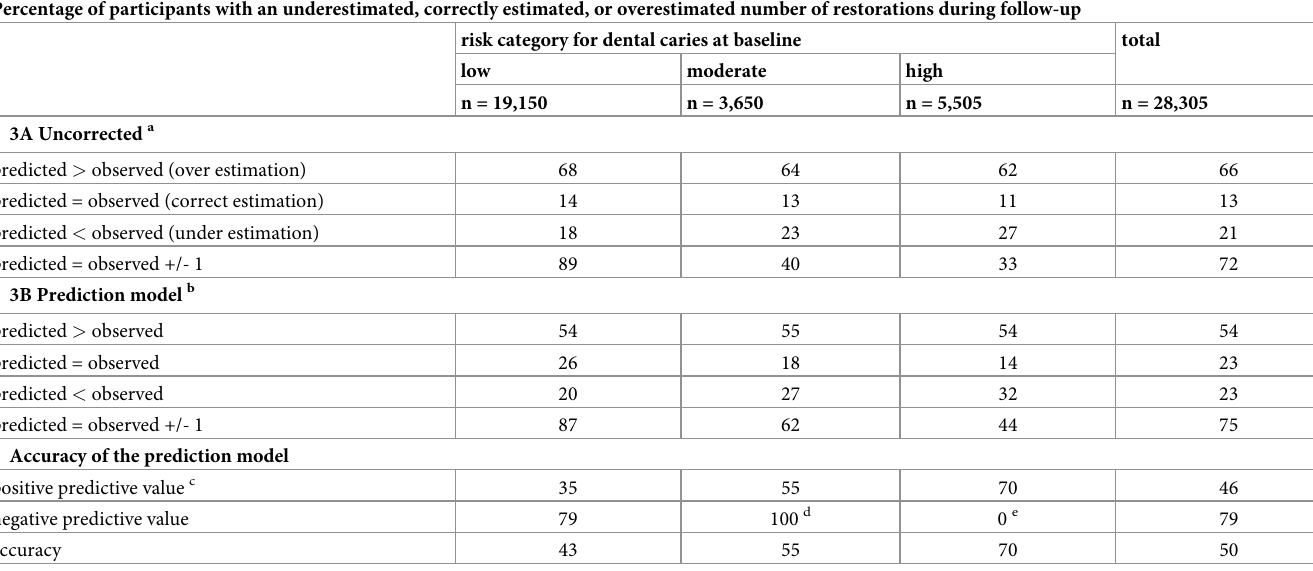
Table 3. Accuracy of the predicted number of restorations at